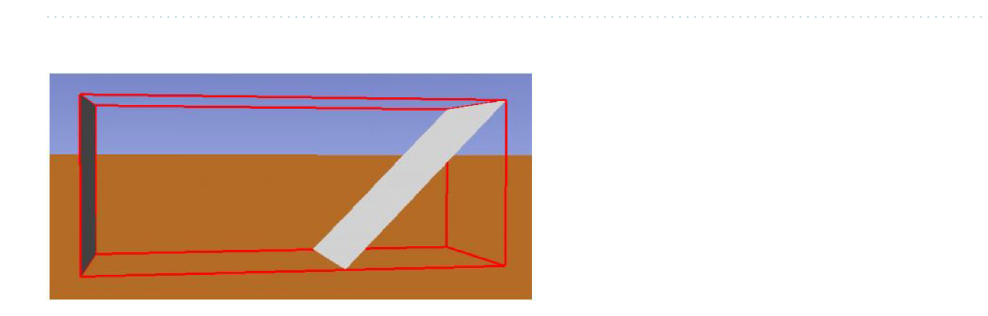
Figure 3. Characteristics Responsible for deviations from the Ideal Reflection (Adapted from 26 ).